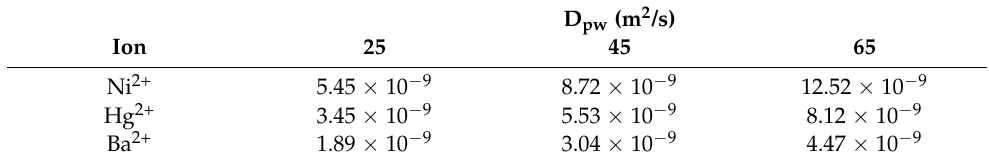
Table 4. Diffusion parameters of ions in water at (25, 45, and 65 ◦ C).